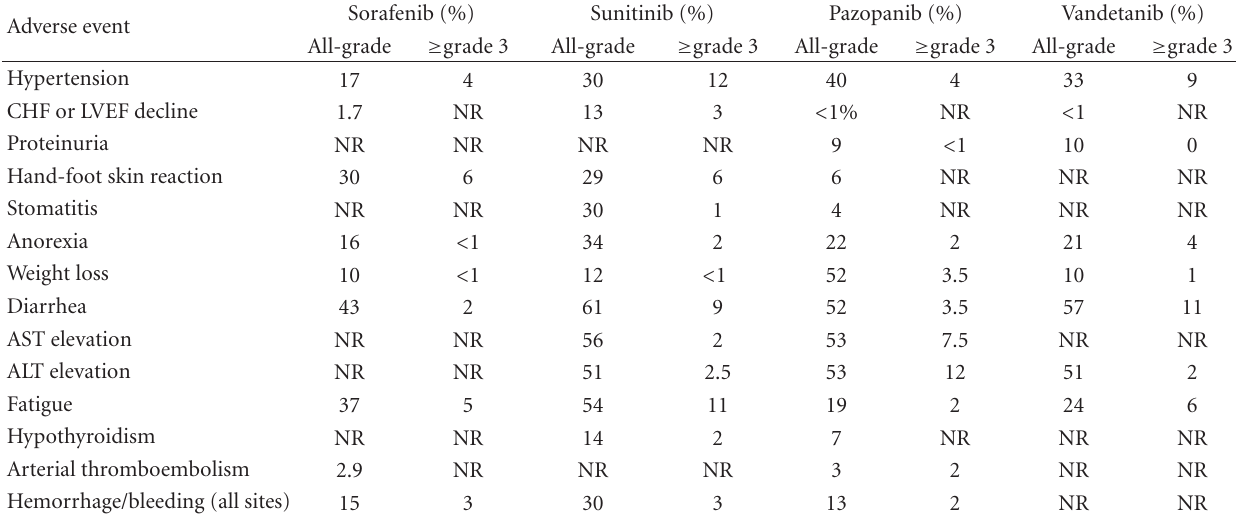
Hypothyroidism Arterial thromboembolism Hemorrhage/bleeding (all